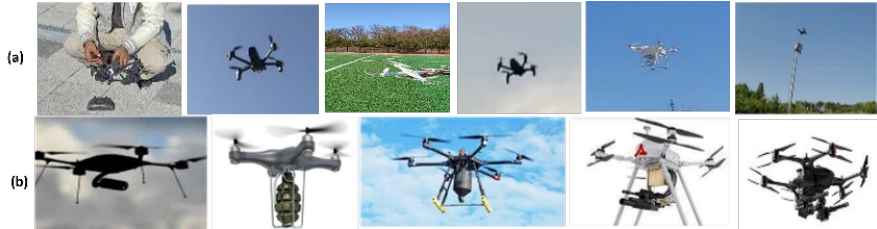
Figure 8. ( a ) Images of dataset capturing and flown drones at different altitudes and climate; ( b ) im- ages of drones with attached